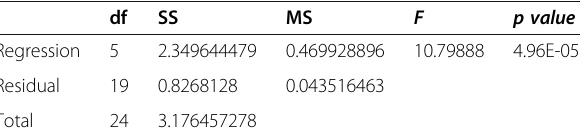
Table 1 Regression statistics